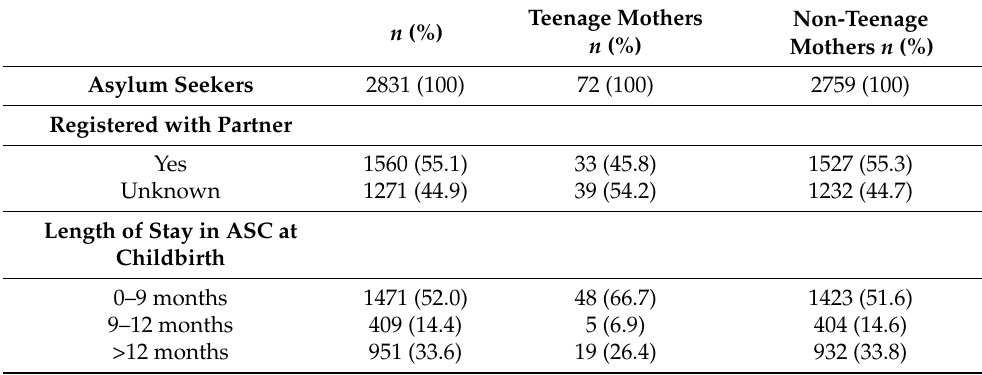
Table 3. Registration with partner and length of stay in teenage and non-teenage